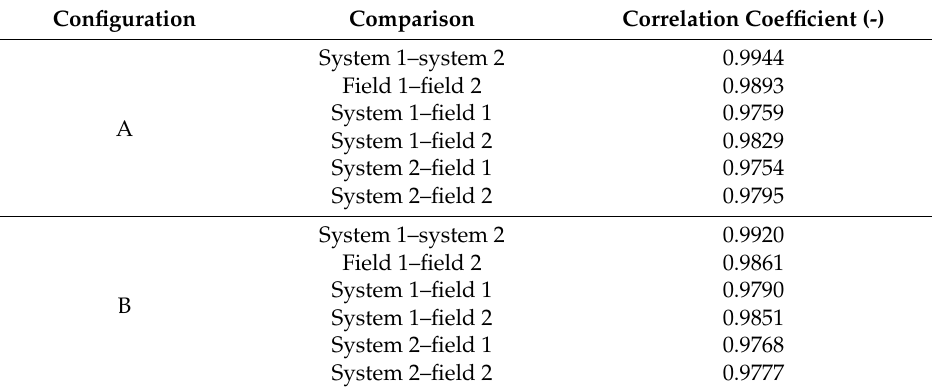
Figure 11. Transverse spread pattern, configuration A ( a ) and B ( b ). Two replicates were measured with the camera system (system) and in the field using collection trays (field). Table 8. Correlation coefficients between transverse spread patterns for configuration A and B measured with the camera system and with collection trays on the field. A grid resolution of 1 m × 1 m was used (51